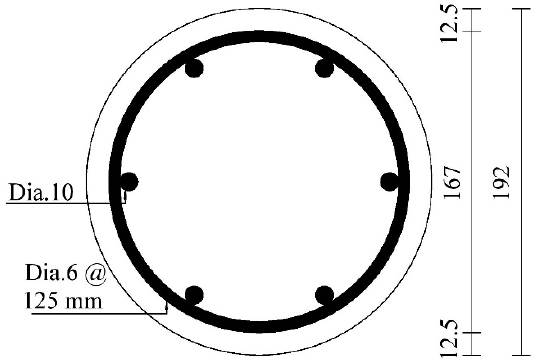
Figure 5. Cross-sectional and steel reinforcement details of specimen selected from [26] for a para- metric analysis.